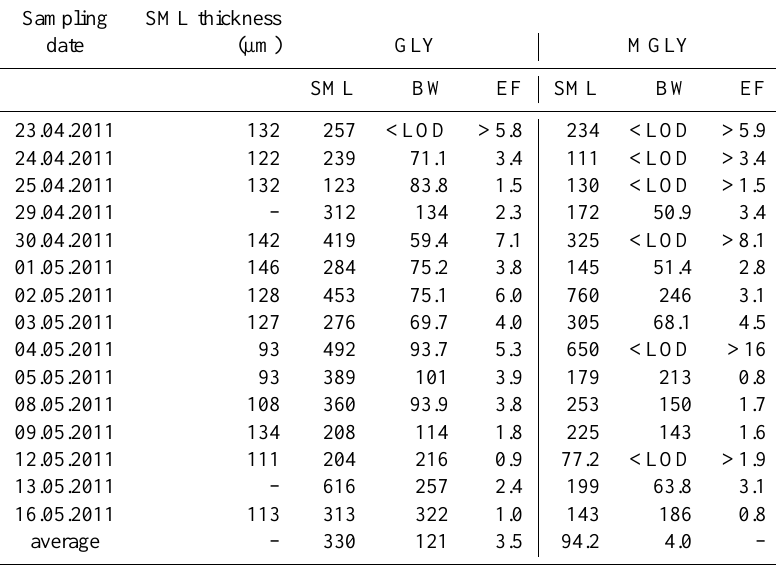
Table 3. Surface microlayer thickness, GLY and MGLY concentrations in surface microlayer (SML) and bulk water (BW) and corresponding enrichment factor